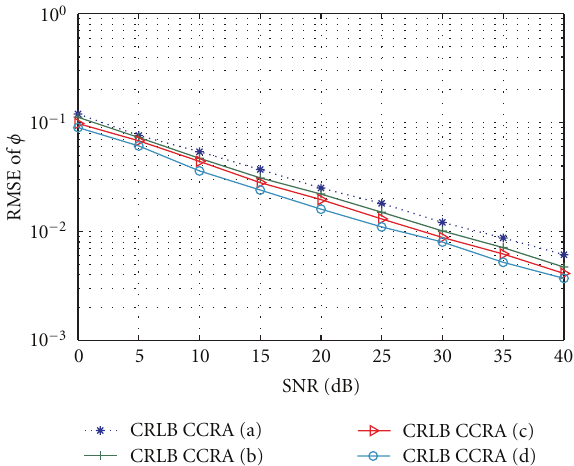
Figure 2: CRLB of estimated azimuth for four di ff erent arrange- ments: (a), (b), (c), and (d) of CCRA.